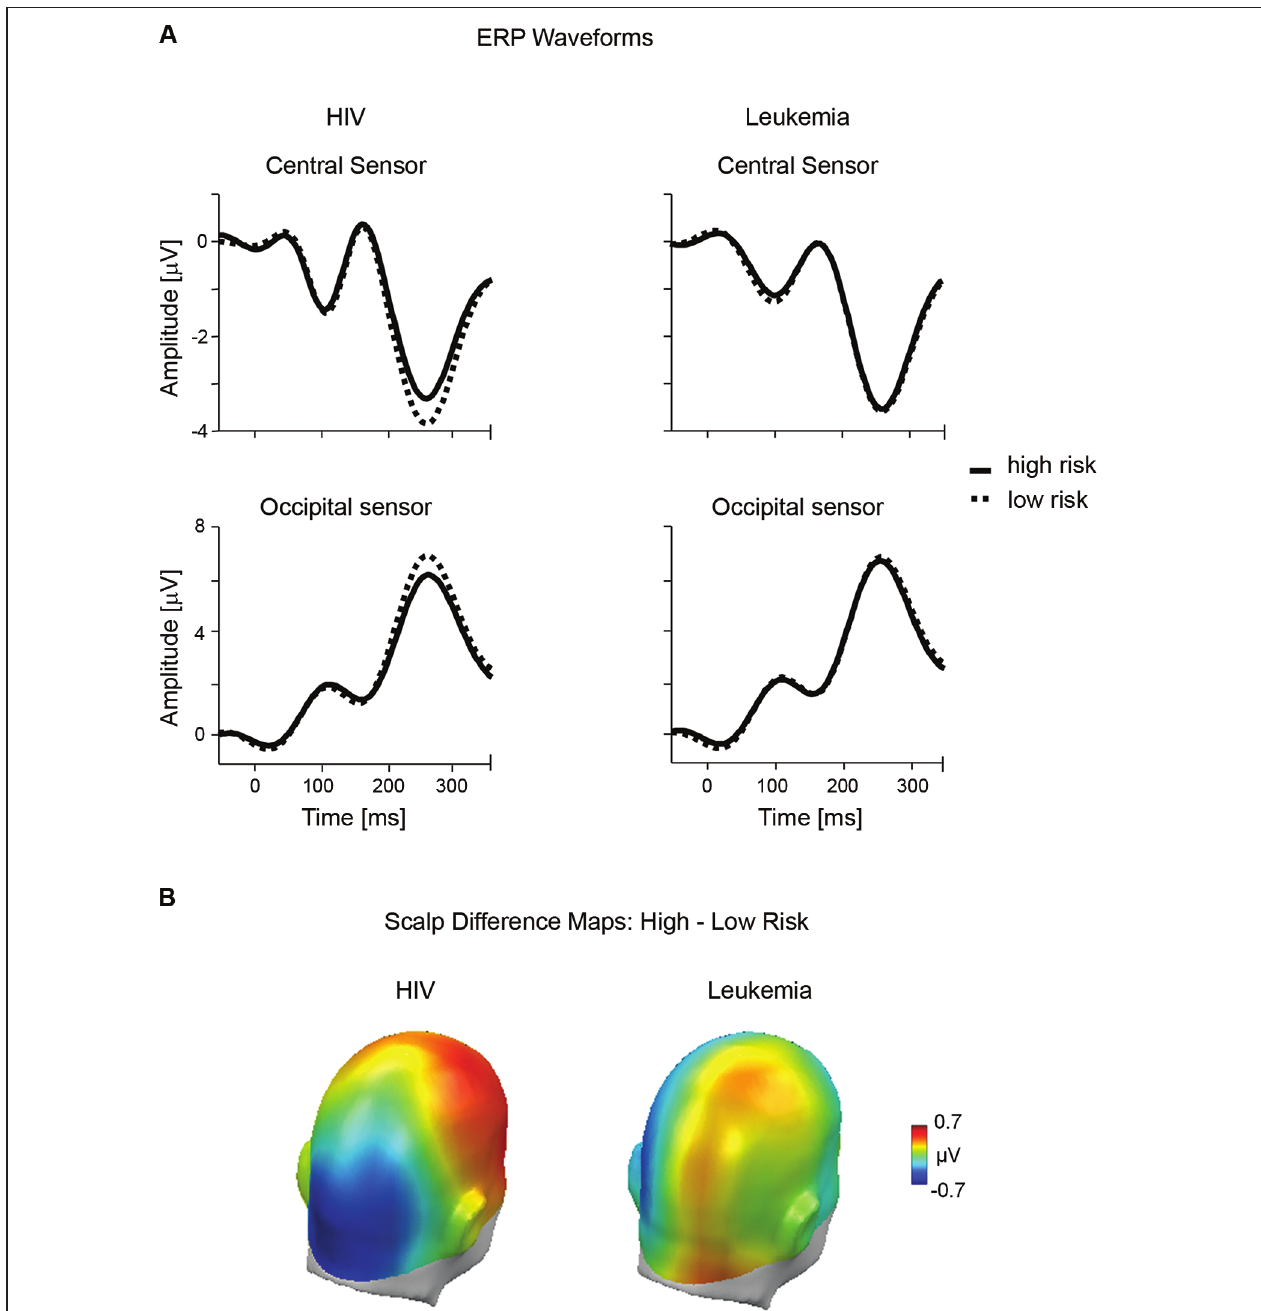
potential map shows the topography of the difference between the high and low risk categories for HIV and leukemia risk averaged across the time window from 200–300